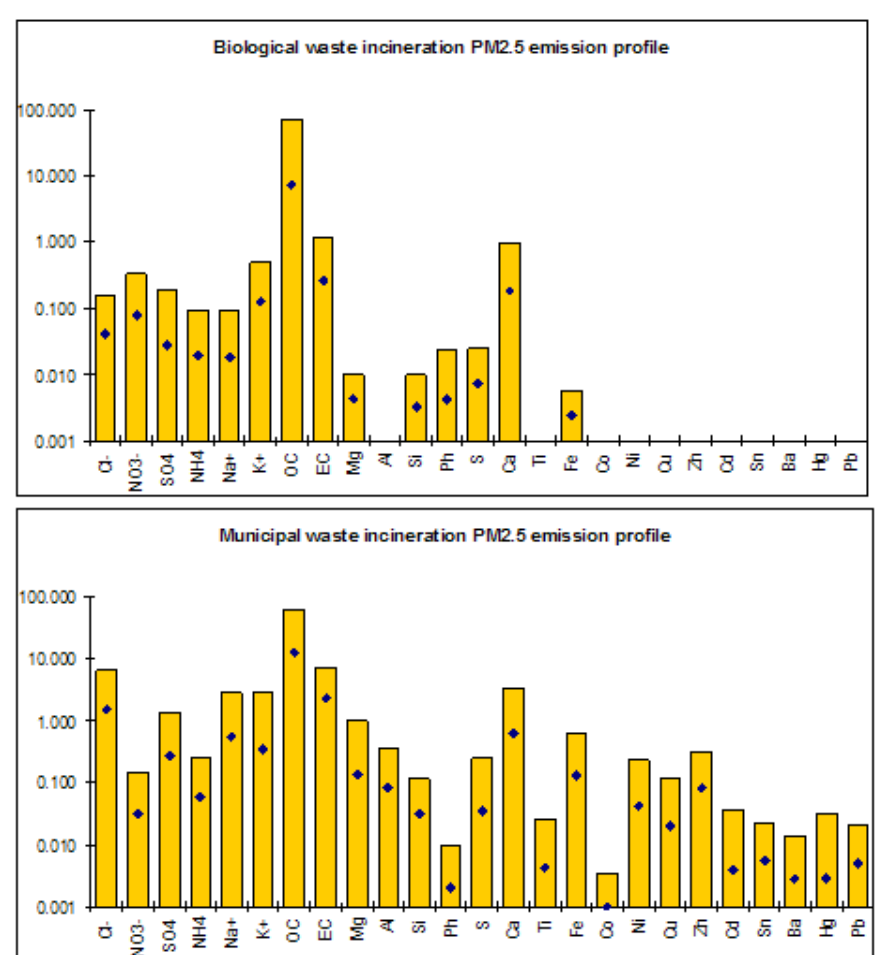
FIGURE 3 . Comparison of BWI and MWI PM 2.5 emission profiles. Dots represent